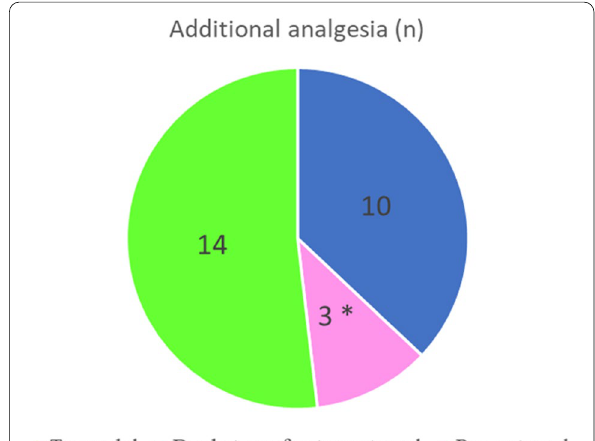
Fig. 5 Graphical presentation of additional analgesia. * p <0,05 refers to between groups comparisons